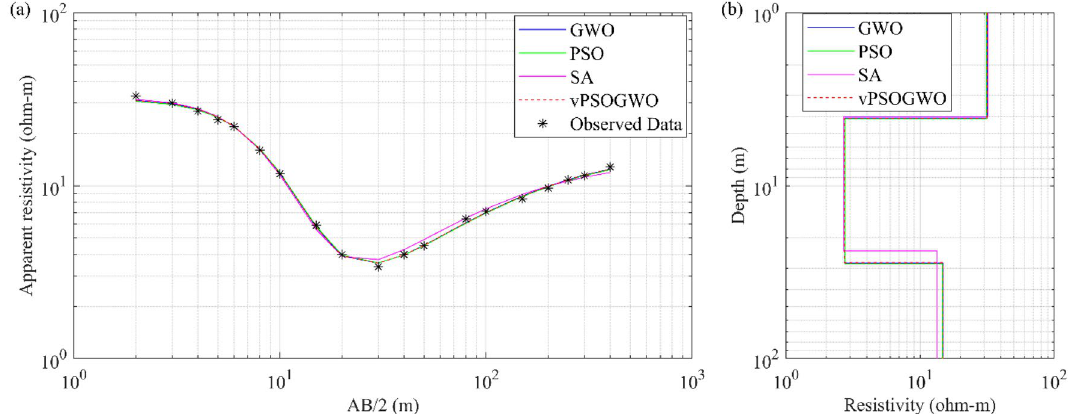
Figure 13. Three-layers DC field data over Digha, Medinipur (WB), India: ( a ) observed (*) and the best-fitted apparent resistivity curves using GWO, PSO, SA, and vPSOGWO; ( b ) 1-D mean model (bpdf > 68.27% CI) inverted by vPSOGWO (red), SA (magenta), PSO (Green) and GWO (Blue).